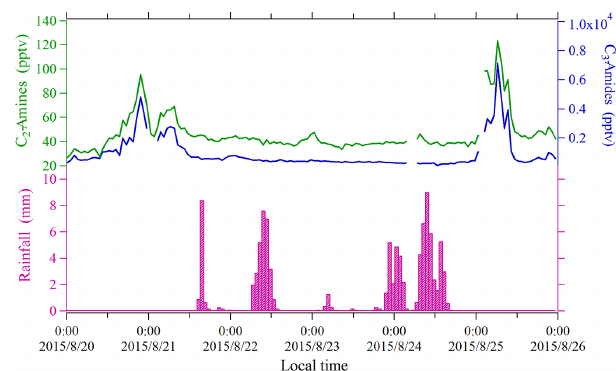
Figure 6. Time profiles of the rainfall, C 2 -amines, and C 3 -amides.